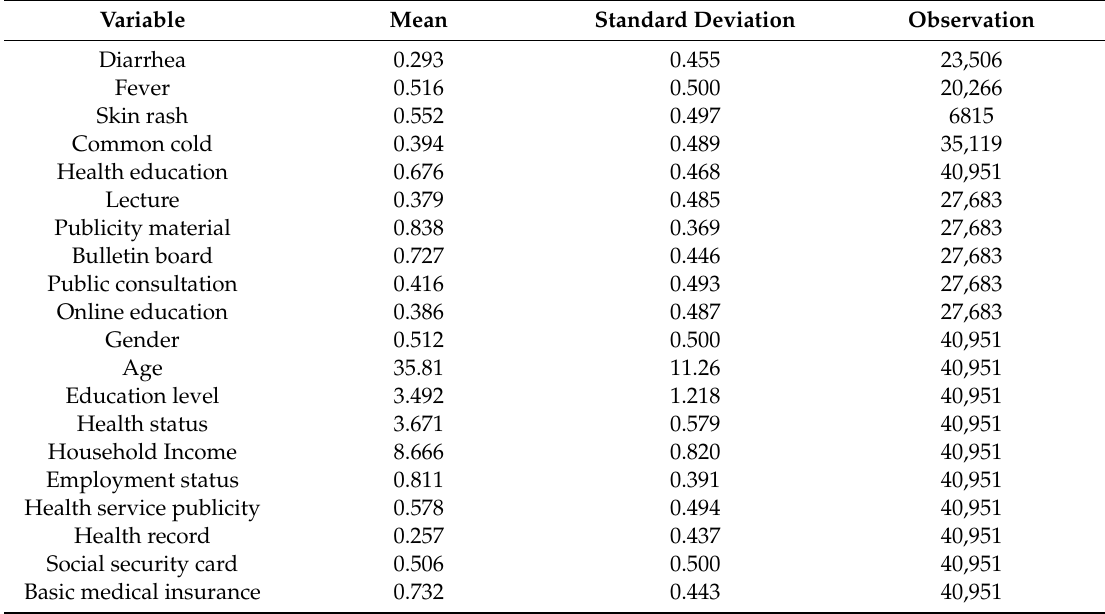
Table 1. Descriptive statistics of